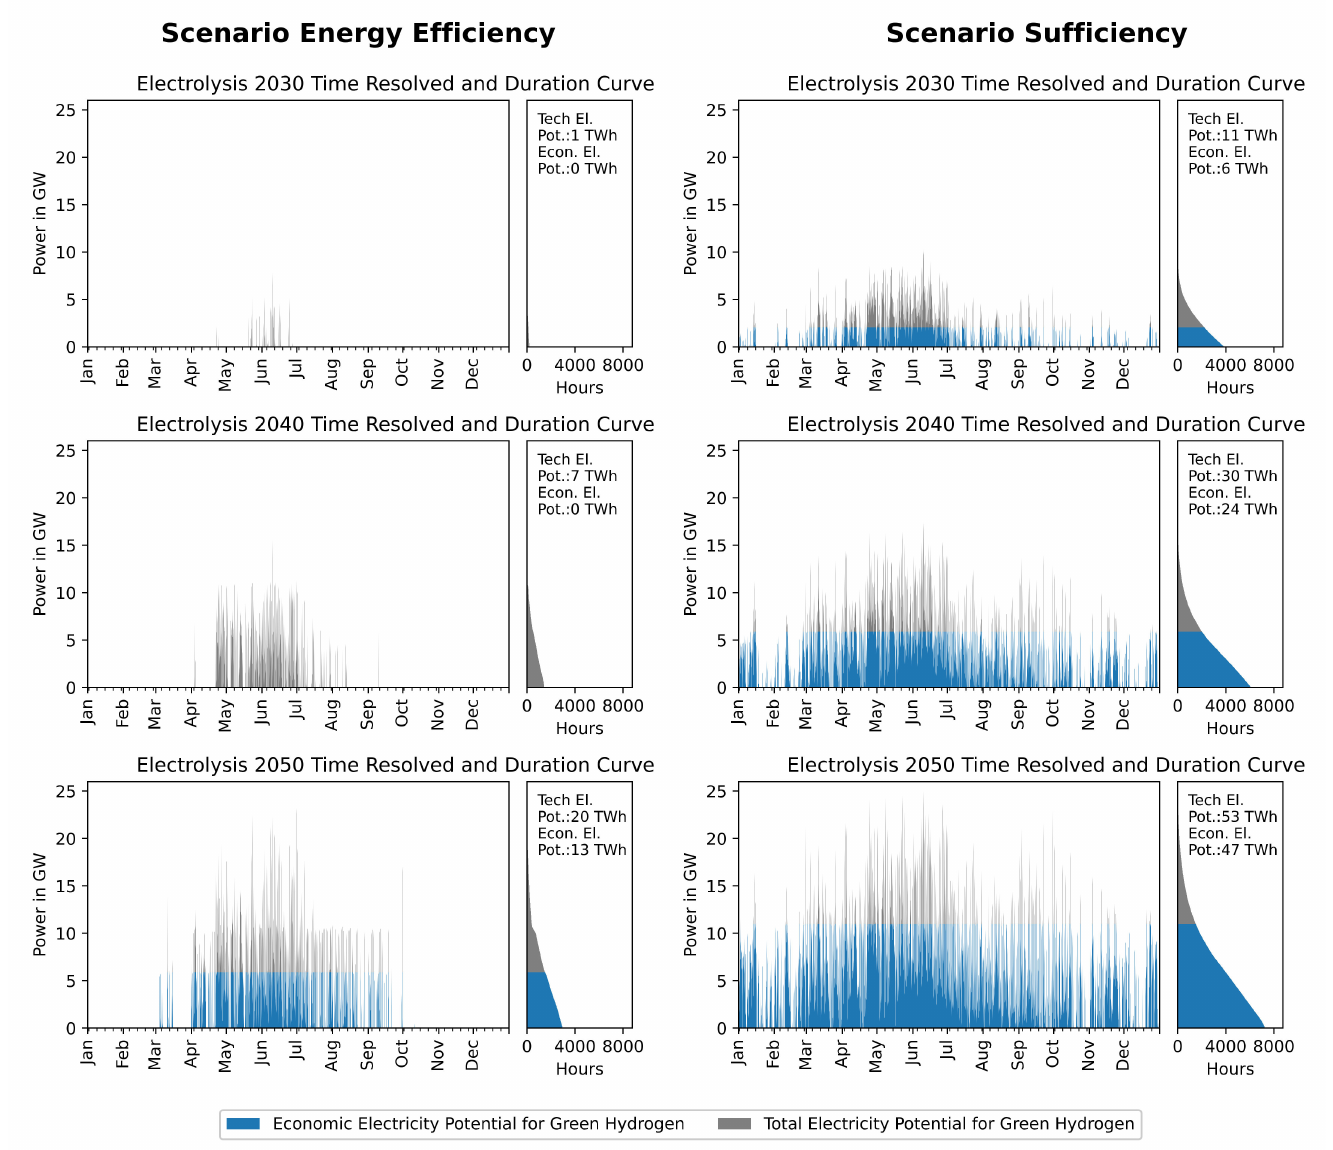
Figure 6. Technical potential of negative residual load usable by electrolysis (grey) as well as the economically realisable potential (blue). For each scenario and each considered year, the temporally resolved diagram (always left) and the ordered duration curve (always right) is